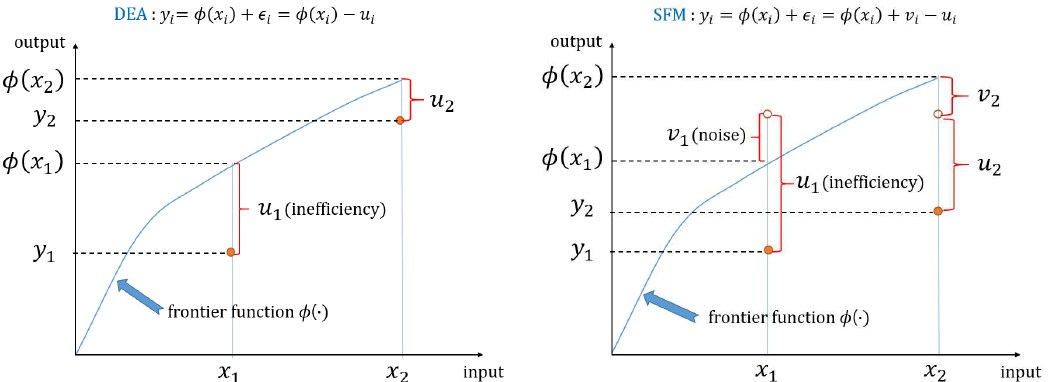
Figure 1. Comparison between Data Environment Analysis (DEA) ( left panel ) and SFM ( right panel ) frameworks ( y i : output, x i : input, φ ( x i ) : the maximum output which can be obtained from the input x i , (cid:101) i : deviation from the production frontier function φ ( x i ) , u i : technical inefficiency, v i : noise). Note